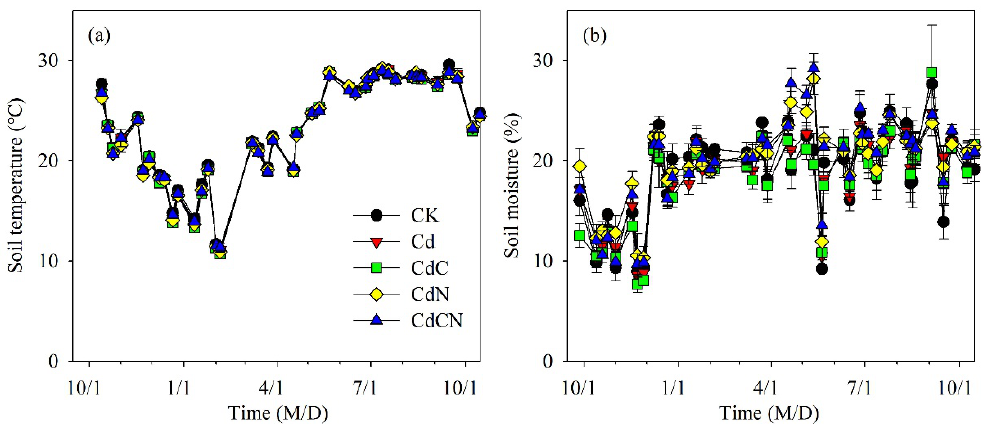
Figure 1. Seasonal dynamics of soil temperature at the 10-cm depth ( a ) and soil moisture content within the top 10 cm of the soil profile ( b ) as affected by five treatments: CK (the control; with ambient Cd, ambient CO 2 , and ambient N deposition); Cd (with Cd addition, ambient CO 2 , and ambient N deposition); CdC (with Cd addition, elevated CO 2 , and ambient N deposition); CdN (with Cd addition, N addition, and ambient CO 2 ); and CdCN (with Cd addition, elevated CO 2 , and N addition). Treatment effects were not statistically significant for soil temperature ( p = 0.77) or soil moisture ( p = 0.56). Values are means ± SE ( n = 3).